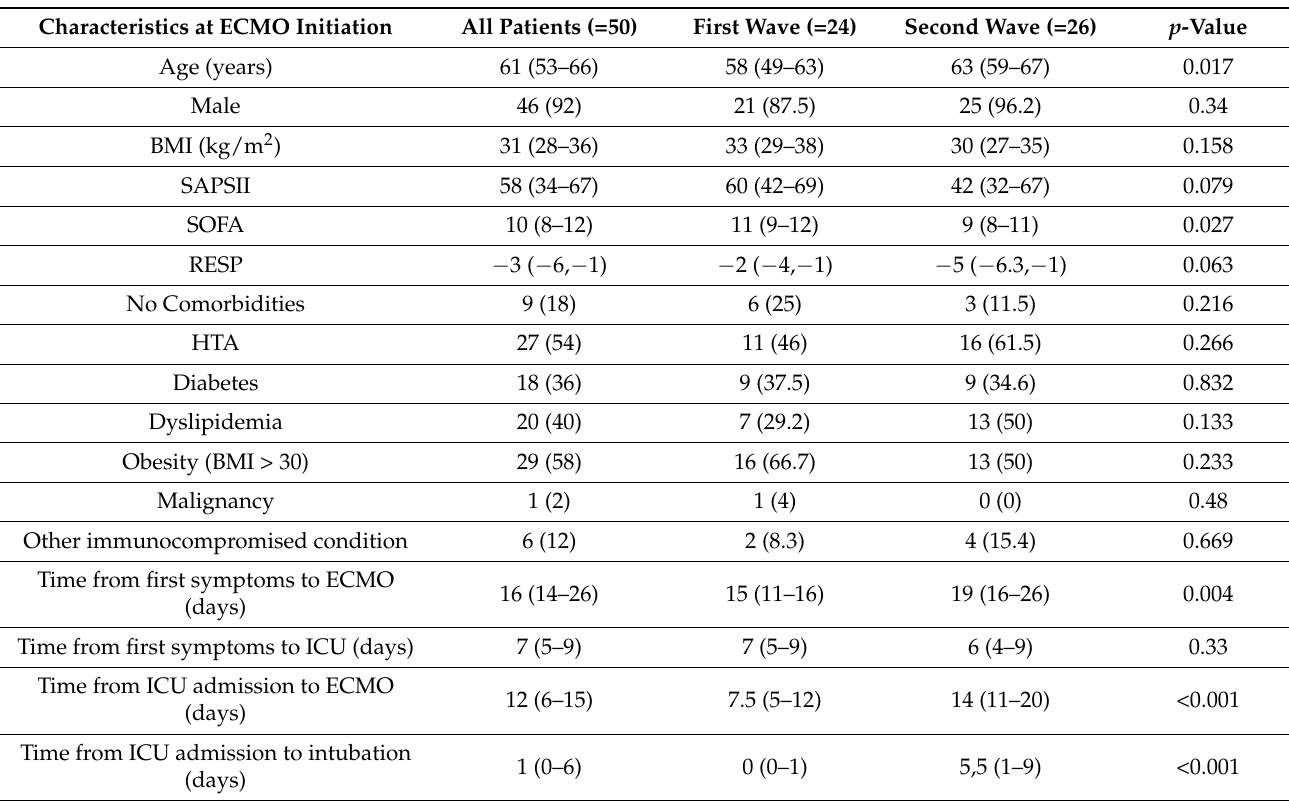
Table 1. Patients’ characteristics at veno-venous extracorporeal membrane oxygenation (V-V ECMO) initiation in the first and second wave